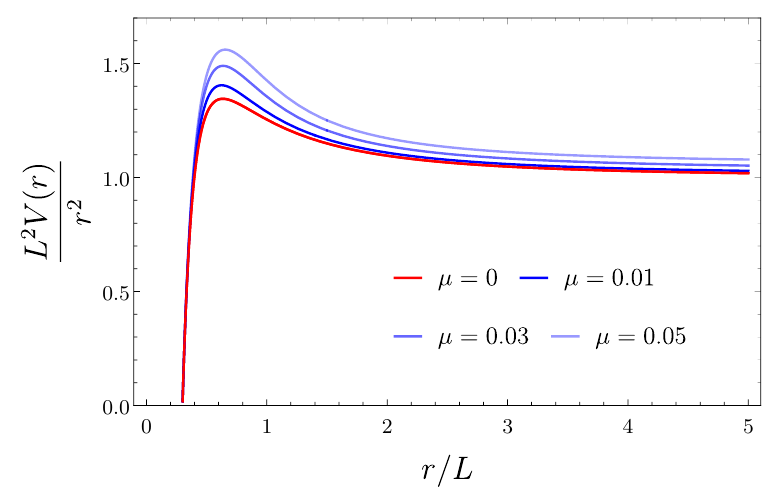
Figure 1 . We plot the metric function V S 2 ( r ) (cid:1) L 2 =r 2 corresponding to Taub-NUT solutions of ECG with n=L = 0 : 3 for several values of (cid:22) . The examples shown correspond to values of (cid:22) and n which satisfy the positive-mass inequalities (2.21). The red curve corresponds to the metric function for the Einstein gravity Taub-NUT solution given by (2.11) with k =